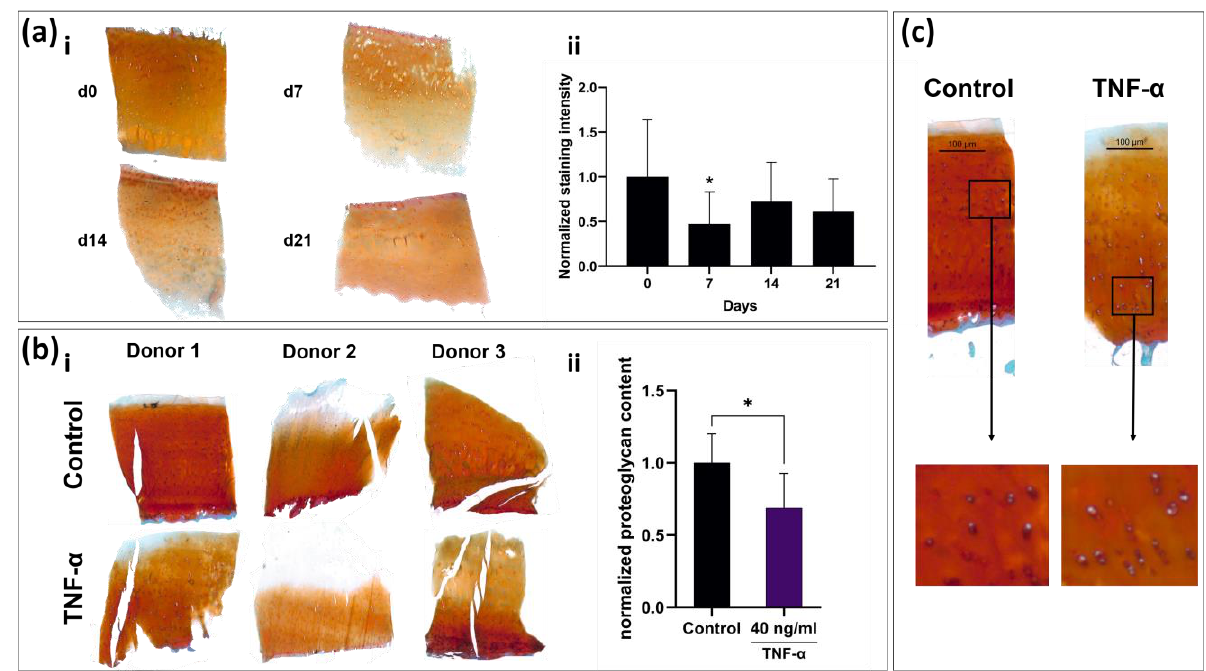
Figure 3. Histomorphometrical and histological analysis of live slices. ( a ) Safranin-O-stained slices of one donor (i) and histomorphometrical analysis (ii) over three weeks. ( b ) Comparison of staining intensity in TNF- α -stimulated and non- stimulated slices. Stimulated slices (three exemplary donors shown in (i)) show a mean reduction in red intensity of 32% (ii, n = 6). ( c ) Representative picture of TNF- α -treated slice and control. TNF- α -treated slices show less intense Safranin-O staining, loosened matrix structure and swollen cells in the mid-zone of the cartilage. Statistically significant differences denoted as * p < 0.05.